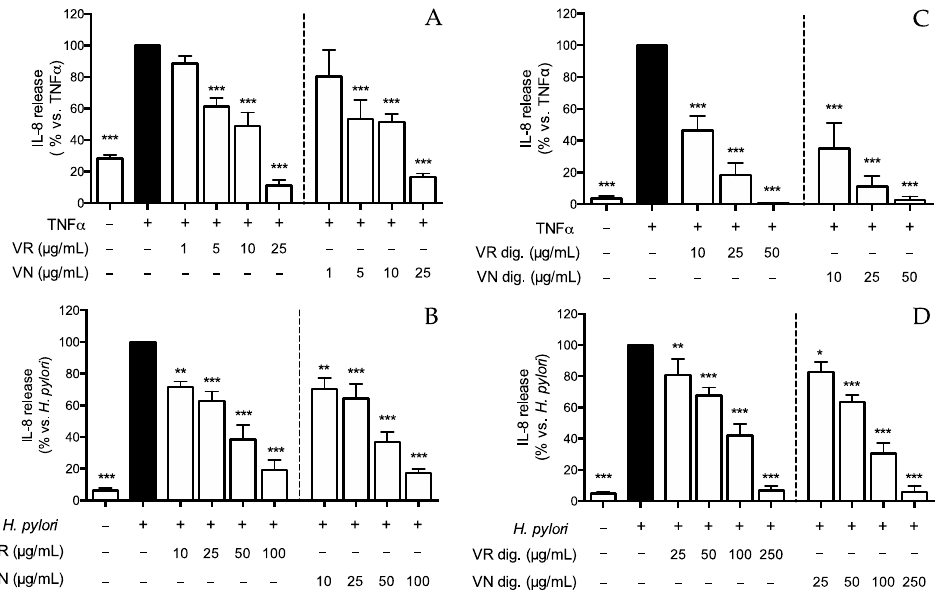
Figure 1. Effect of Castanea sativa Mill. leaf extracts on IL-8 release. GES-1 cells were treated for 6 h with TNF α (10 ng/mL) or H. pylori (ratio 50:1, bacteria/cell), in addition to leaf extracts before ( A , B ) and after in vitro simulated digestion ( C , D ). IL-8 was measured by ELISA assay. Results are expressed as the mean ± SEM ( n = 3) of the relative percentage in comparison to stimulus (black bar), to which the value of 100% was arbitrarily assigned. * p < 0.05, ** p < 0.01, and *** p < 0.001 vs. stimulus. VR, Castanea sativa Mill. var. verdesa leaf extract; VN, Castanea sativa Mill. var. venegon leaf extract; dig., in vitro simulated digestion. Table 4. IC 50 (µg/mL) of the Castanea sativa Mill. extracts on IL-8 release. Before Gastric Digestion After Gastric Digestion